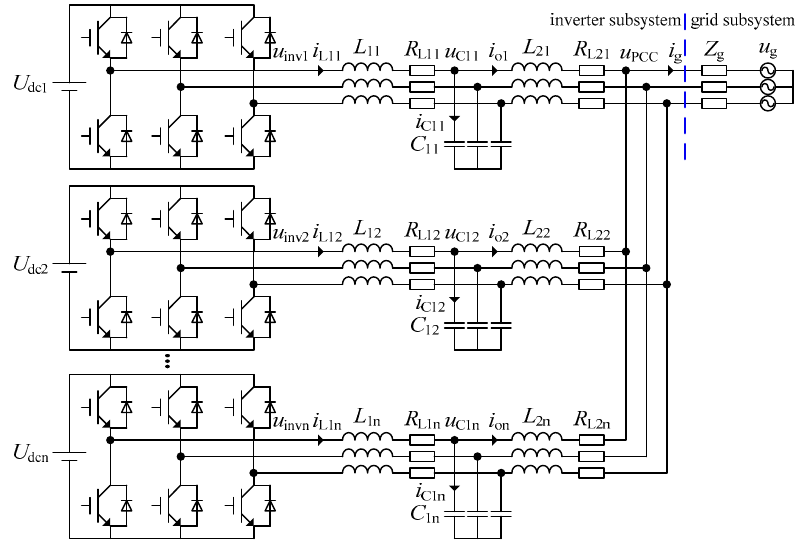
Figure 1. Structure of paralleled multi-inverter system.